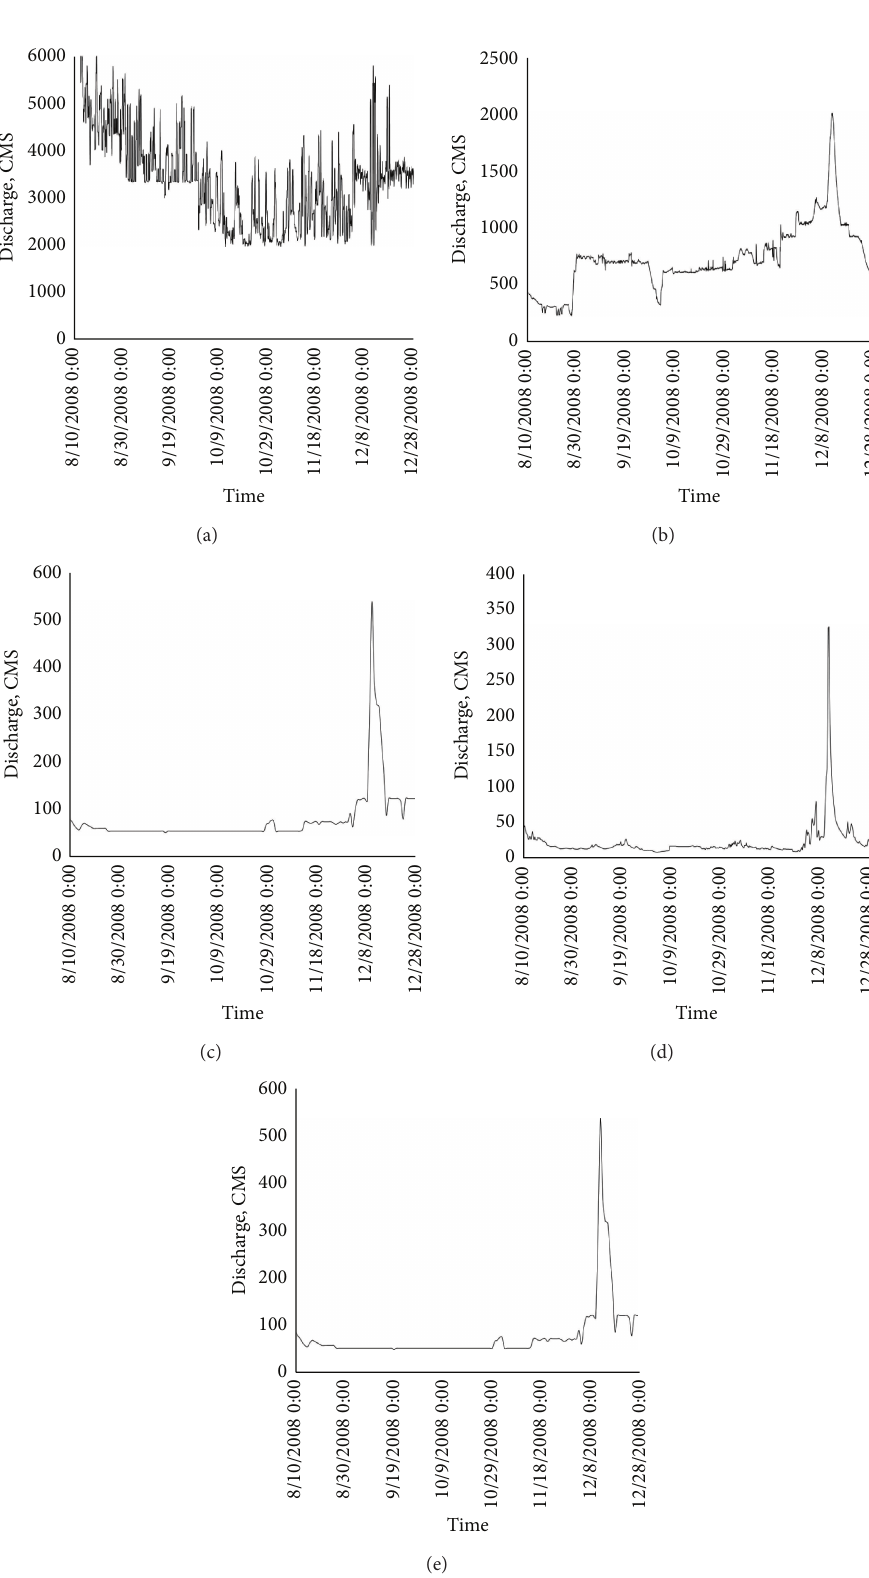
Figure 4: Discharge (a) Bonneville L&D, (b) Willamette Falls, (c) Cowlitz, (d) Sandy, and (e)